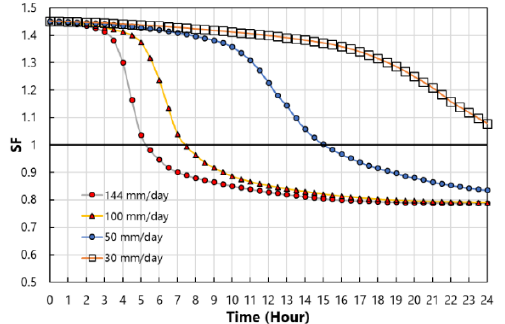
Figure 19. Change in safety factor with time under different flux without overtopping.